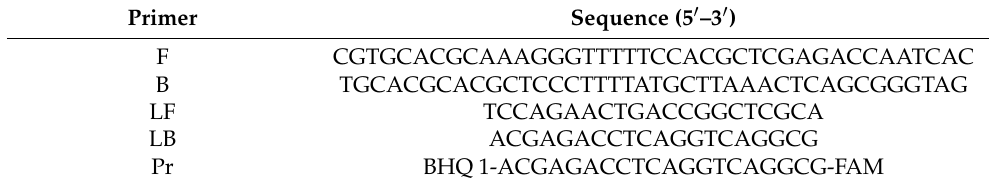
Table 1. LMTIA primer sequences for ITS gene in soybean. Primer